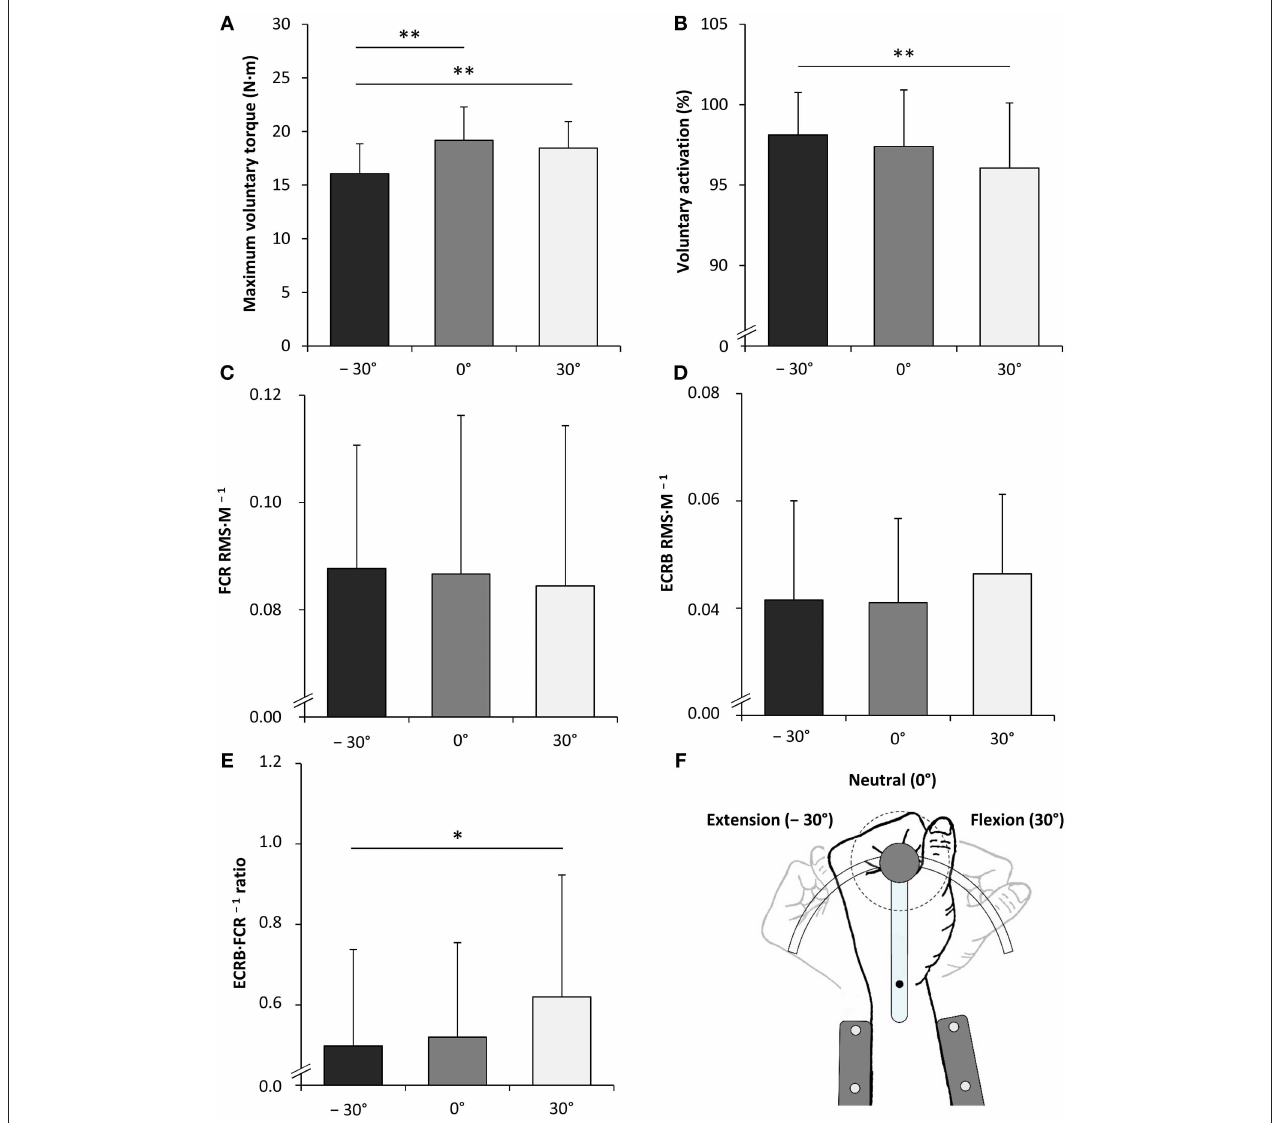
FIGURE 3 | Maximal voluntary torque of the wrist flexors (A) , voluntary activation of the wrist flexors (B) , root mean square of the EMG signal normalized to the maximal M-wave (RMS · M − 1 ) of the flexor carpi radialis (FCR) during MVC of the wrist flexors (C) , RMS · M − 1 of the extensor carpi radialis brevis (ECRB) during MVC of the wrist flexors (D) , the antagonist · agonist − 1 EMG ratio (ECRB · FCR − 1 ratio) during MVC of the wrist flexors (E) and the schematic representation of the experimental setup (F) . − 30 ◦ , extension: long wrist flexor muscle length; 0 ◦ , neutral: intermediate wrist flexor muscle length; 30 ◦ , flexion: short wrist flexor muscle length. *Denotes a significant difference between joint angles (* P ≤ 0.050, ** P ≤ 0.010). Values are expressed as means ± standard